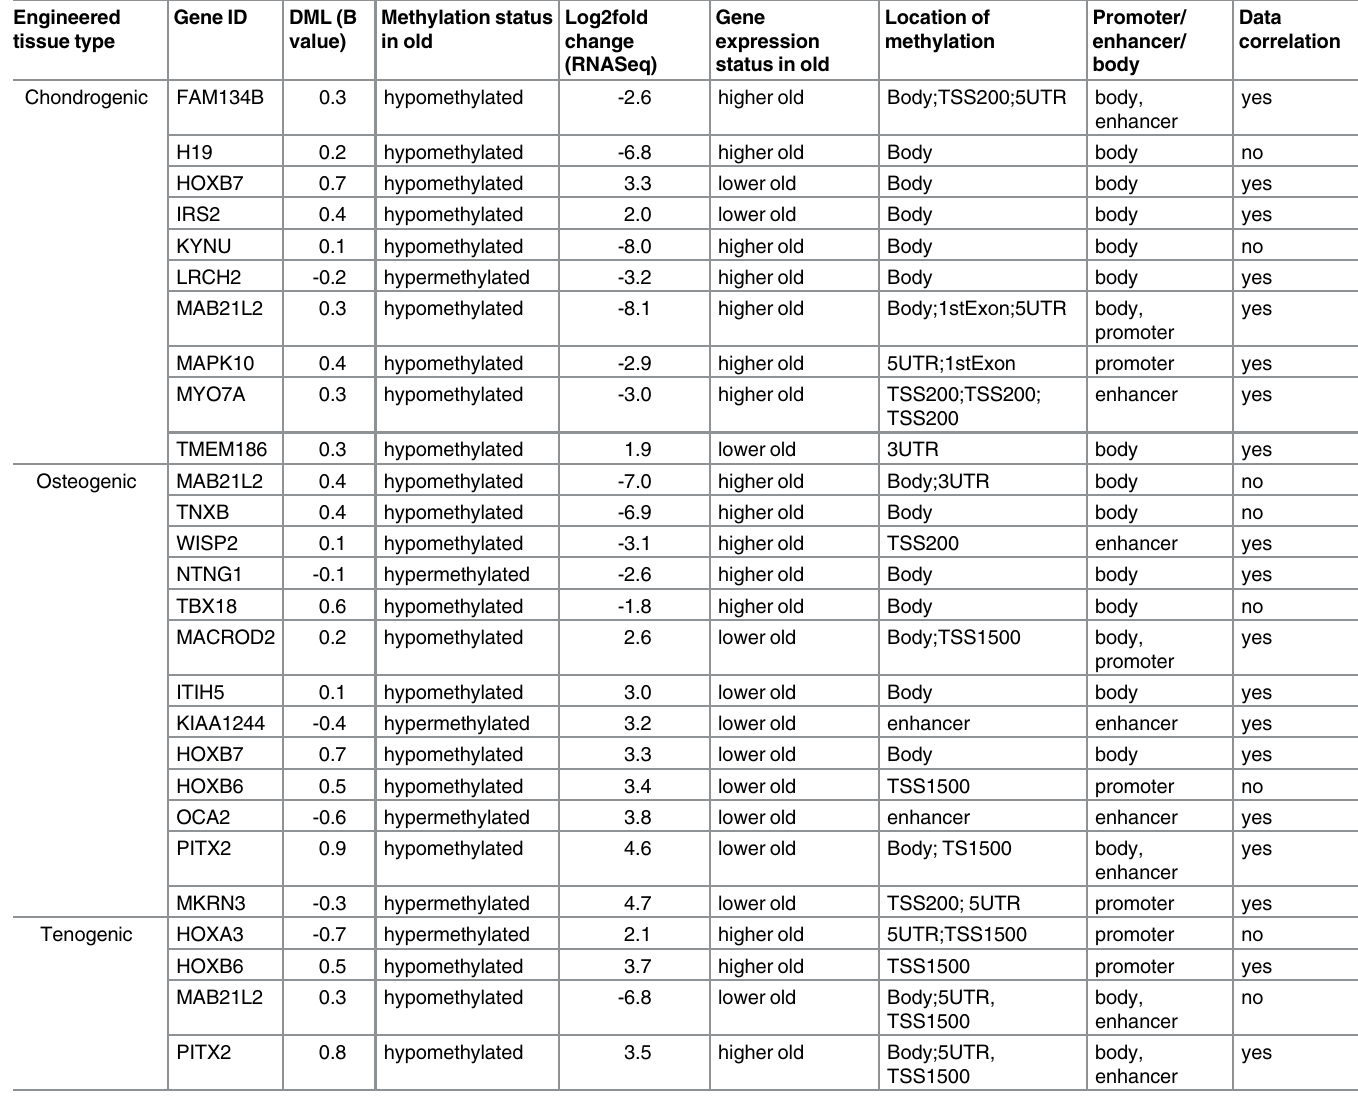
Table 10. Summary of genes and DML correlating relationships for chondrogenic, osteogenic and tenogenic engineered tissues. Engineered tissue